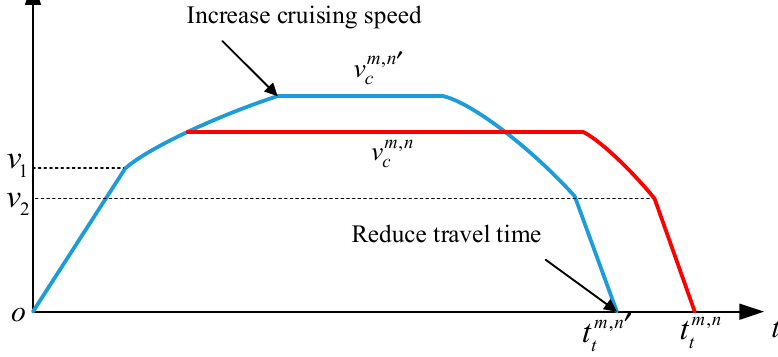
Figure 4. The relation between the cruising speed and the periodic time.